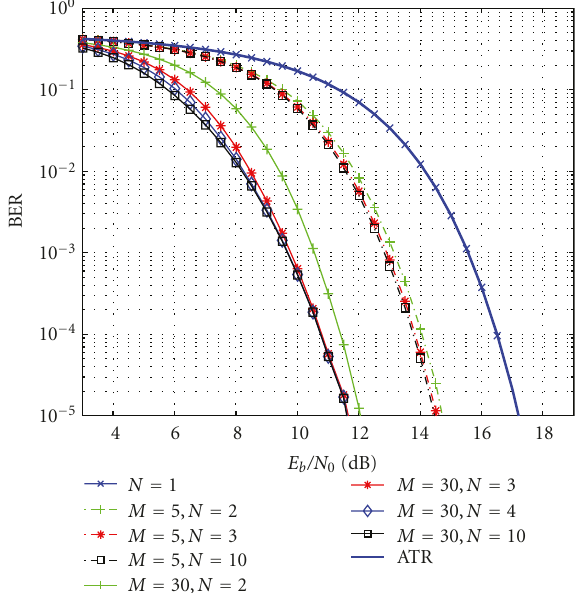
Figure 3: BER of HD-MSTR for di ff erent iterations M = 5, 30, K = 200, N f = 20 .